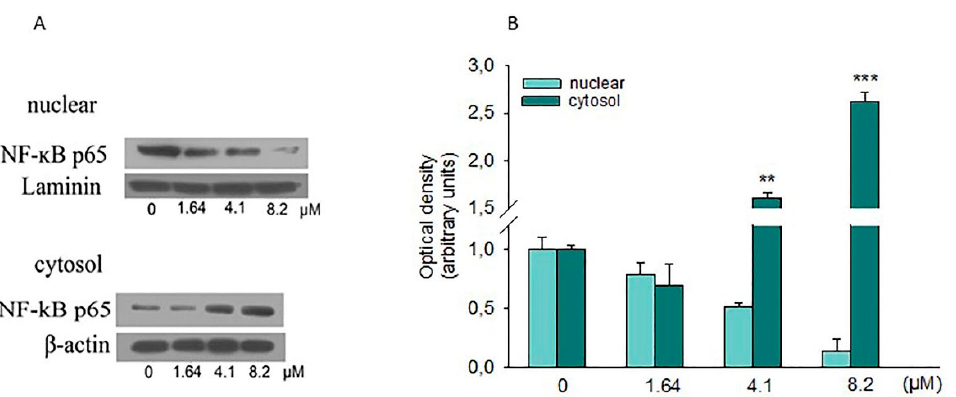
Figure 8. Effects of moringin on NF- ĸ B activation. ( A ) SH-SY5Y cells were treated for 24 h with the indicated concentration of moringin, and then, cytoplasmic and nuclear proteins were analyzed by Western blot for the NF- ĸ B p65 sub-unit. ( B ) Densitometric analysis of autoradiographic bands in which levels of the nuclear protein were normalized for laminin and the cytosolic ones for β -actin. A representative immunoblot of three independent experiments is shown. * p < 0.01, and *** p < 0.001 vs. control, respectively.